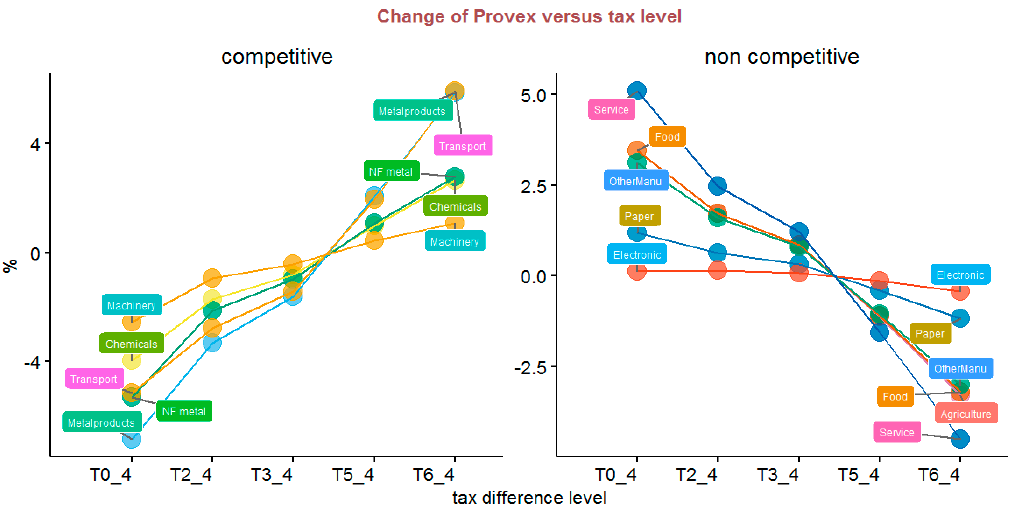
Figure 7. Provincial out fl ow change compared with T4_4 of Guandong Province in 2030.